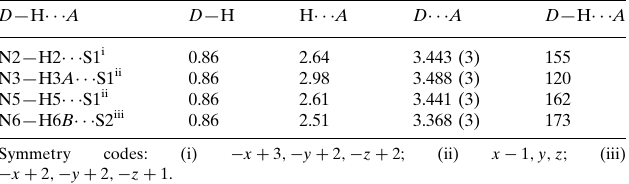
Hydrogen-bond geometry (A˚ , (cid:1)